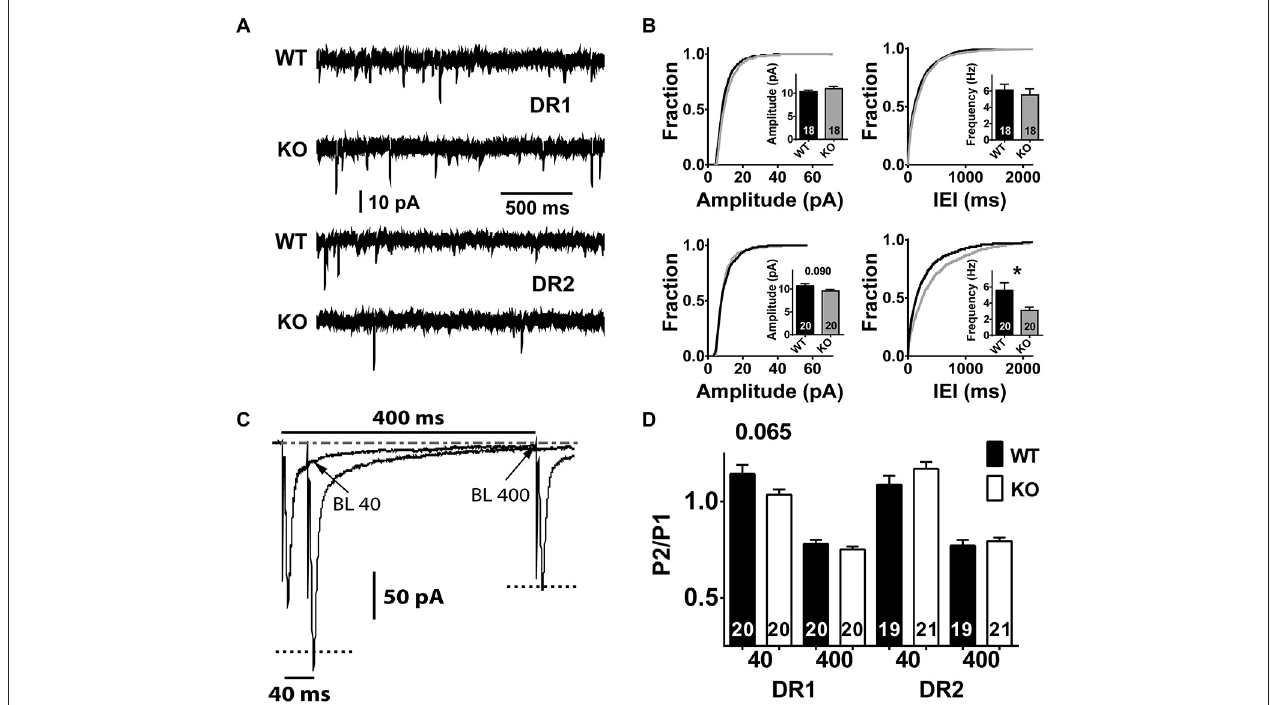
higher number of events. (C) paired pulse ratio (PPR) average traces at IEIs of 40 ms or 400 ms. Downward deflections for stimulation # 1 for both IEIs are superimposed, therefore, only one event is apparent. The current relaxation after the peak for stimulus # 1 (P1) at 400 ms was used to determine the baseline level (BL) for stimulation # 2 (P2) at both IEI 40 ms and IEI 400 ms (P2–40 and P2–400, respectively). Peak amplitude of P2–40 was calculated by subtracting the amplitude of the BL at the time of the peak of P2 (BL 40) from its absolute amplitude. BL400 was taken as the average current amplitude of a 2 ms window just before P2- 400 was triggered. Similarly, peak amplitude for P2–400 was calculated by subtracting BL400 from the absolute peak value for the corresponding event. The dashed-dotted line at the top corresponds to the steady-state baseline. Dotted lines in both P2s correspond to their recalculated amplitudes after baseline subtraction. (D) No significant changes in PPR were identified between genotypes in either pathway, though a trend is apparent in DR1 neurons at IEI of 40 ms. * P < 0.05.